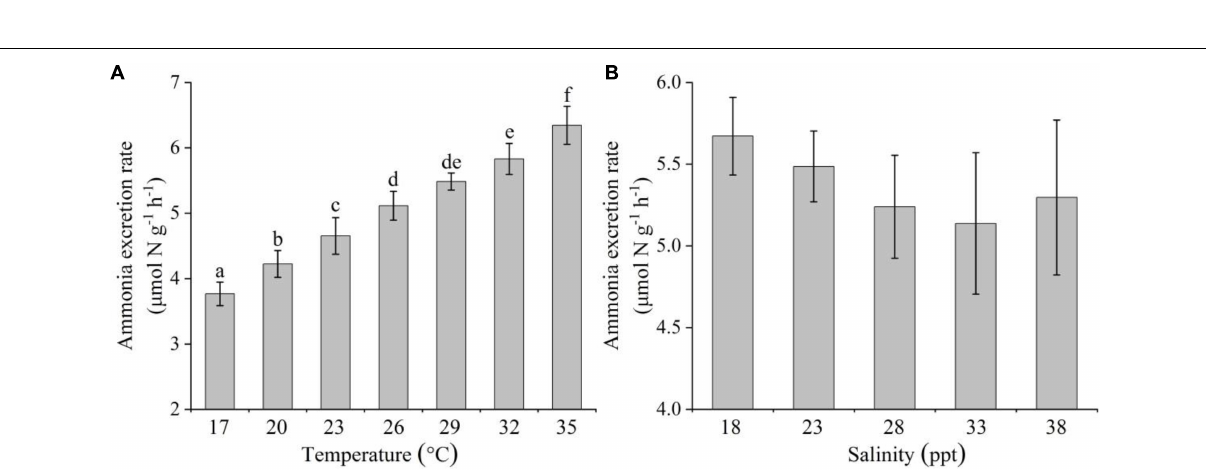
FIGURE 3 | Effects of temperature (A) and salinity (B) on the ammonia excretion rate of Creseis acicula . Bars denote standard deviation. Different superscripts indicate significance ( P < 0.05) among the different temperature and salinity treatments, respectively.